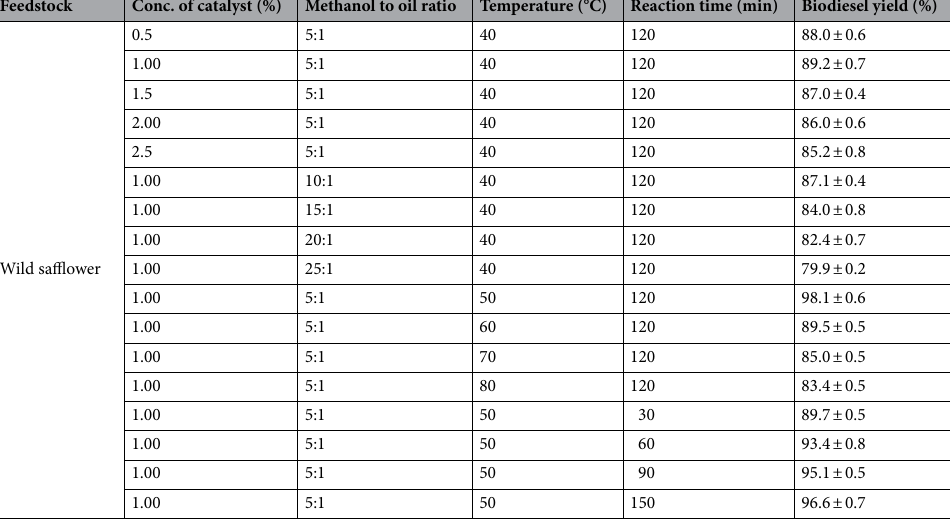
Table 5. Transesterification reaction parameters for wild safflower seed oil.